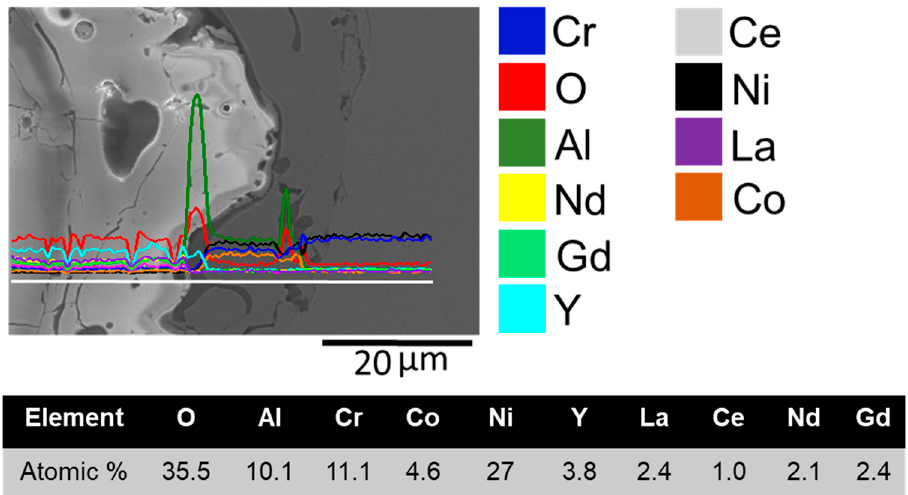
Figure 5. Line scans obtained from the cross-section of the REO coating.